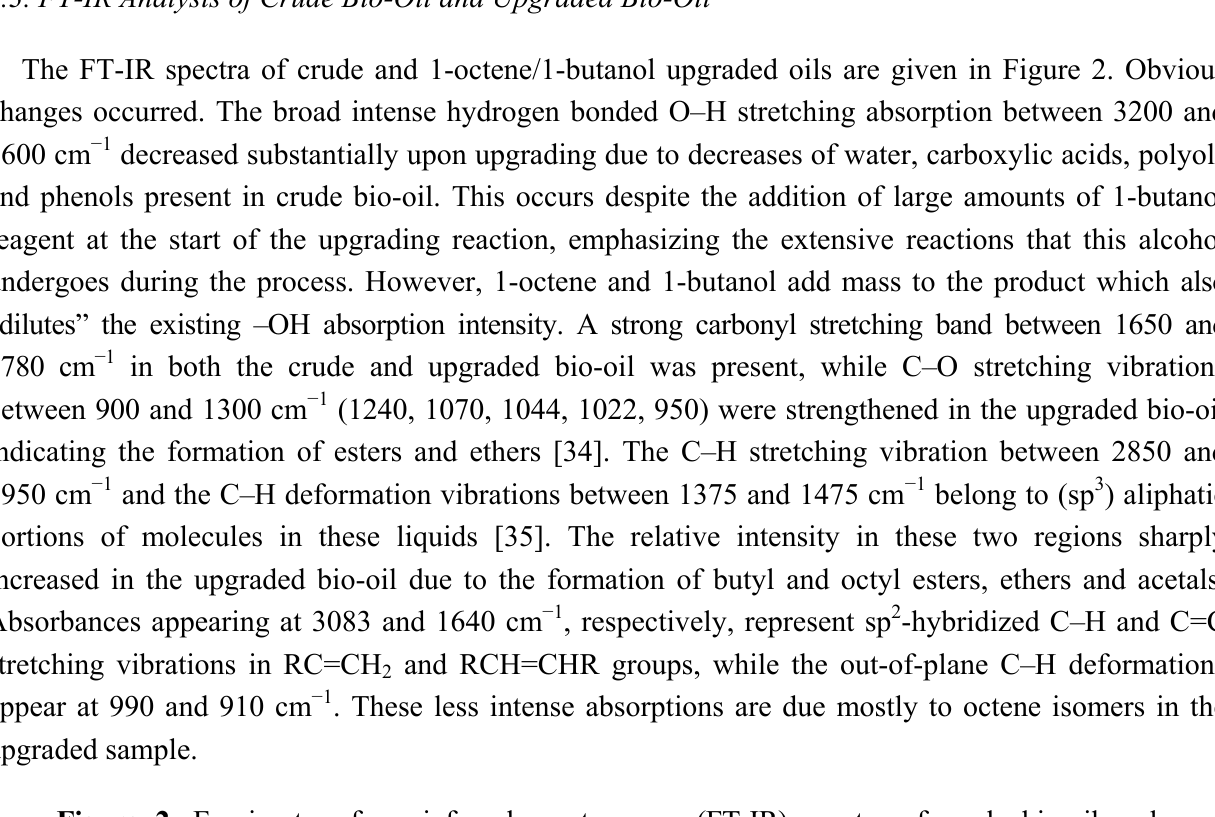
Figure 2. Fourier transform infrared spectroscopy (FT-IR) spectra of crude bio-oil and bio-oil upgraded with a bio-oil/1-octene/1-butanol wt ratio of 1.5/0.6/0.75 at 120 °C after 3 h over